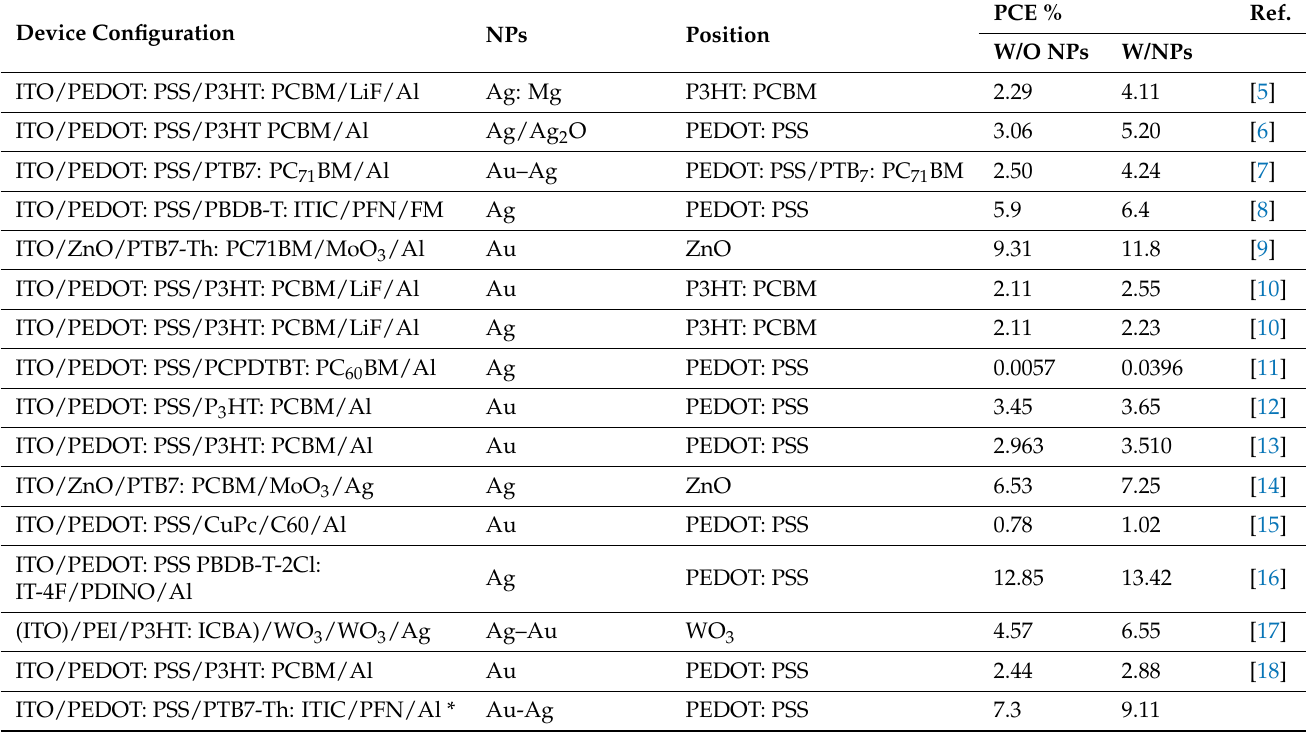
Table 1. Comparisons of power conversion efficiency of organic solar cells with and without nanopar- ticles incorporated in the different parts of the